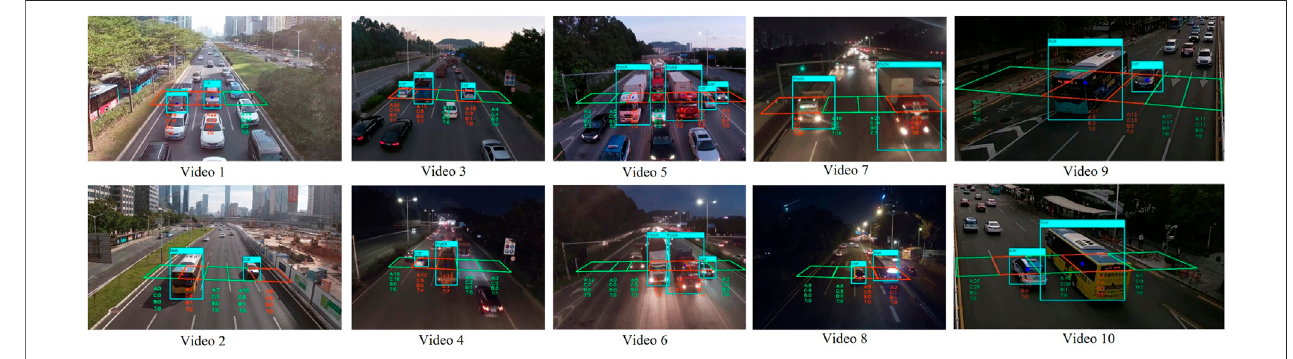
FIGURE 7 | Screenshots of vehicle counting in traf fi c videos.